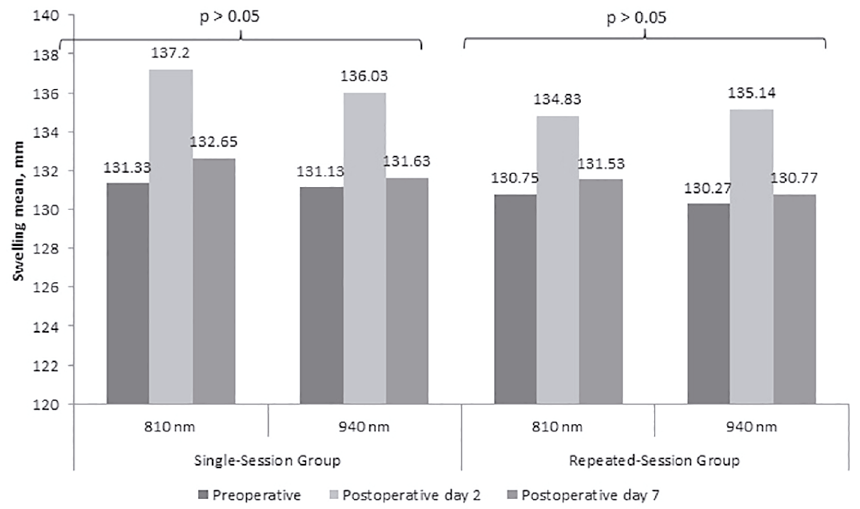
Figure 5- Comparisons of the 810 nm and 940 nm groups in terms of swelling in single-session and repeated session laser